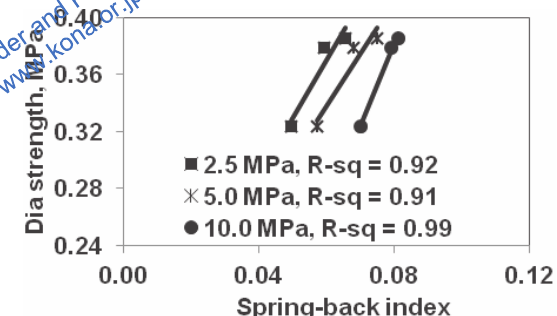
Fig. 6 Relation between tablets ʼ diametral strength and spring-back index (determined at 20 MPa/min loading rate) at different